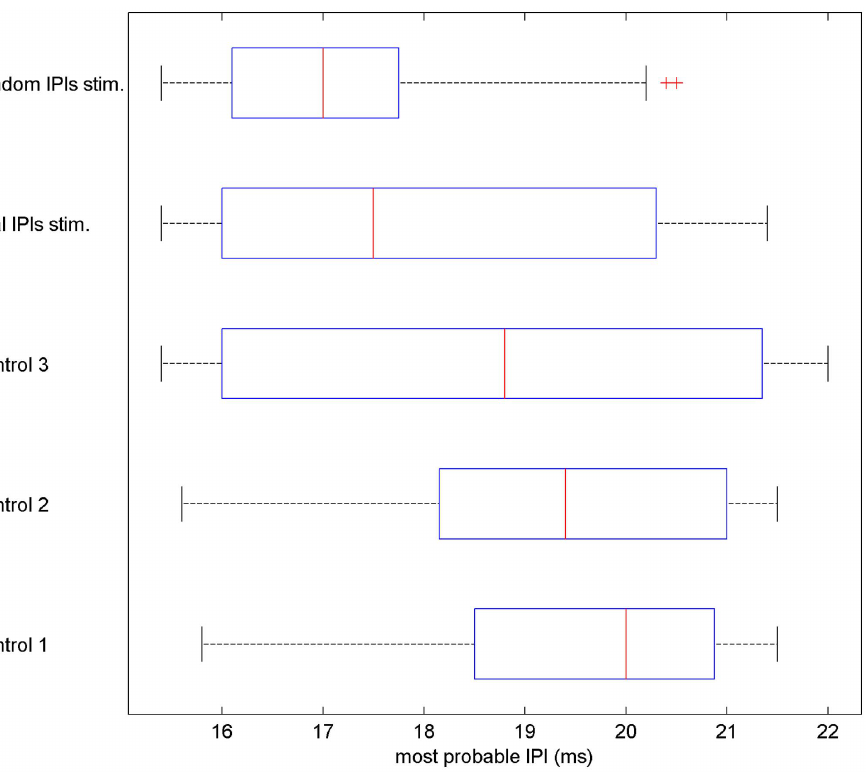
Figure 7. Most probable IPIs for control and stimuli sessions. The most probable IPIs discharged during the stimuli sessions were smaller than those for the control sessions, the medians were 17.0 ms, 17.5 ms, 18.4 ms, 18.8 ms and 19.4 ms for the real IPI stimuli session, random IPI stimuli session, control 3, control 2 and control 1, respectively. Fish responded differently to the real IPI stimuli sessions compared to the random IPI stimuli ones discharging smaller IPIs (Wilcoxon p , 0.05). However, there were no differences among the most probable IPIs discharged during the control sessions (no stimuli sessions; Friedman p . 0.05).